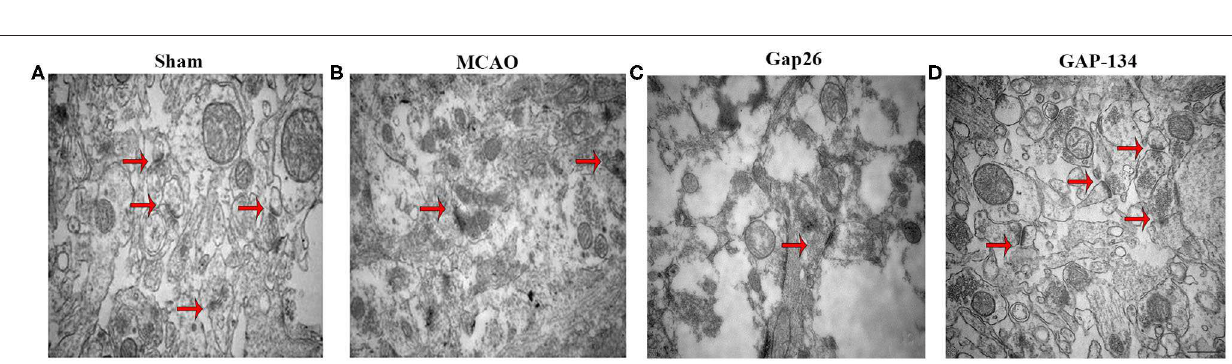
FIGURE 3 | Effects of Gap26 and GAP-134 on dendritic morphology detected by Golgi-Cox staining at 7 d after MCAO. Data were presented as mean ± SEM, n = 3. (A) Representative Golgi-Cox-stained sections in hippocampal CA1, CA3, and DG. Scale bar = 20 µ m. (B–D) Quantitative analysis of spine density in CA1, CA3, and DG. The spine number was decreased in the MCAO, and Gap26 treatment further decreased it in CA1, CA3, and DG while GAP-134 alleviated the decrease in CA1 and DG (* P < 0.05 vs. sham, # P < 0.05 vs. MCAO).